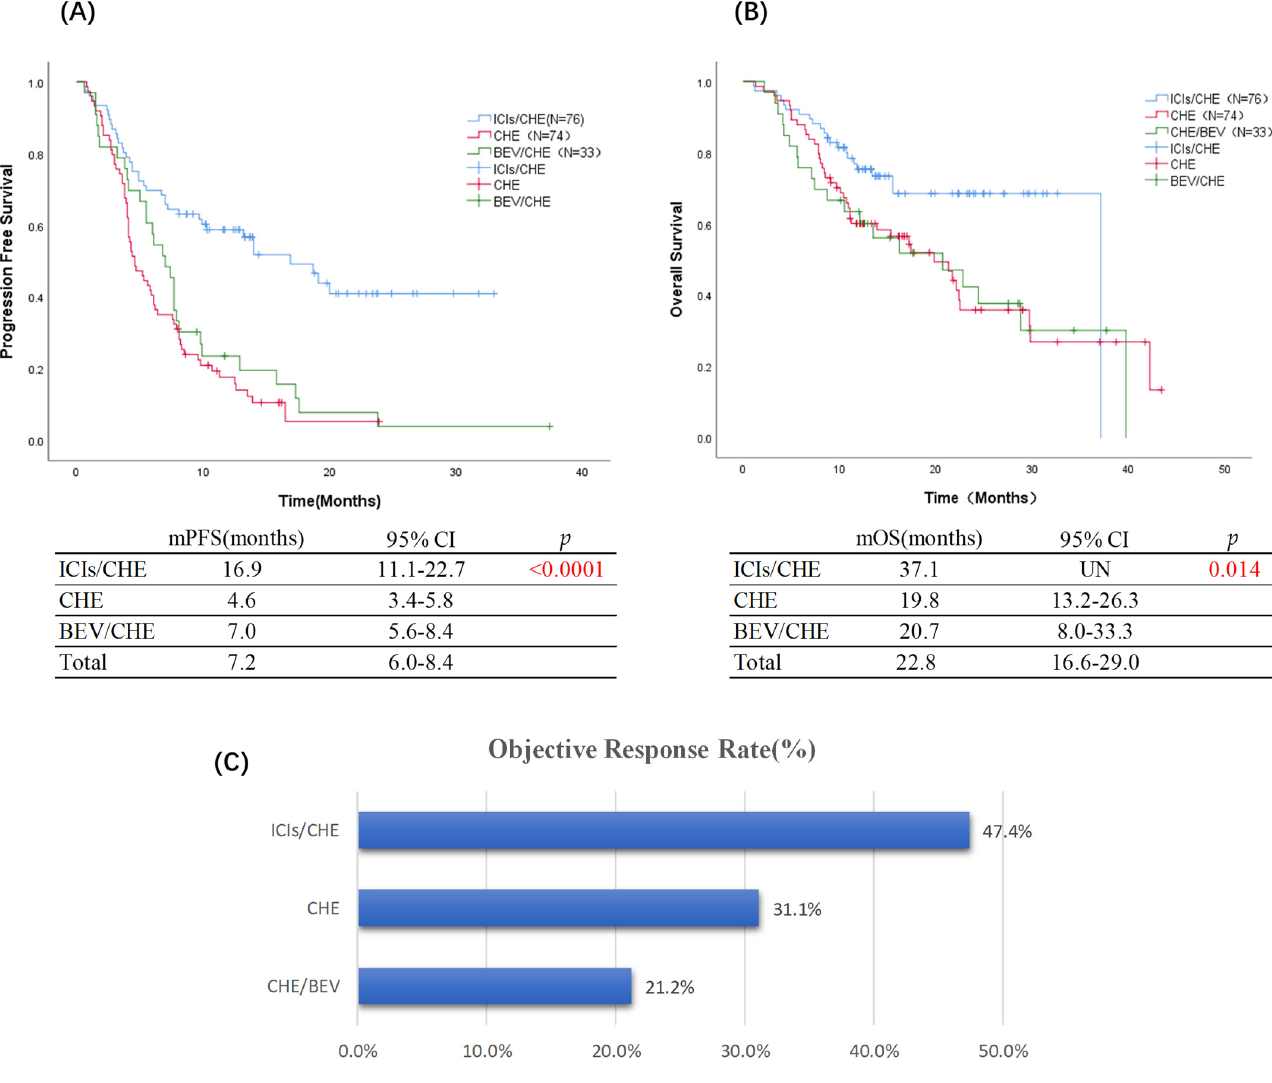
Figure 3. KaplanMeier estimates in the whole cohort ( p < 0.05, statistical significance; p < 0.001, significant statistical significance, red indicates); ( A ) Progression-free survival ( ICIs/CHE vs. CHE vs. CHE/BEV = 16.9 months vs. 4.6 months vs. 7.0 months, p < 0.0001); ( B ) Overall survival ( ICIs/CHE vs. CHE vs. CHE/BEV = 37.1 months vs. 19.8 months vs. 20.7 months, p = 0.014); ( C ) Objective Response Rate ( ICIs/CHE vs. CHE vs. CHE/BEV = 47.4% vs. 31.1% vs. 21.2%).